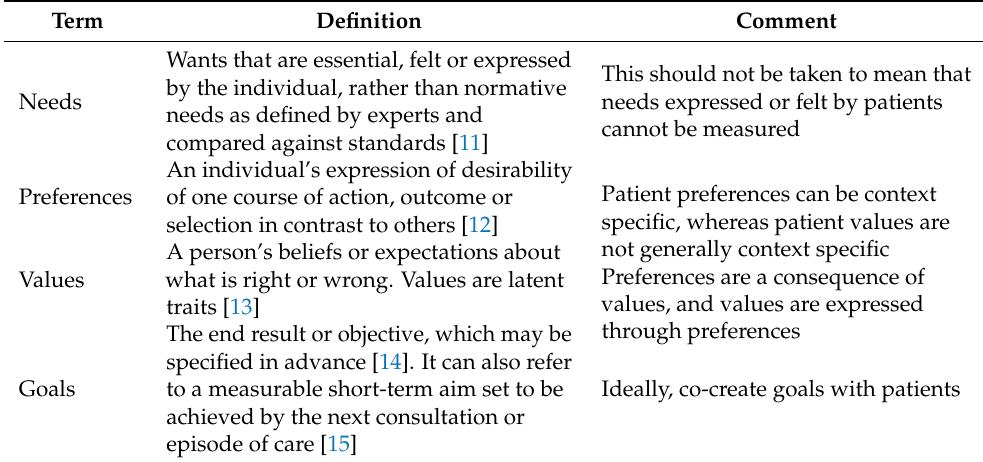
Table 1. Definitions of commonly used terms in patient-centred